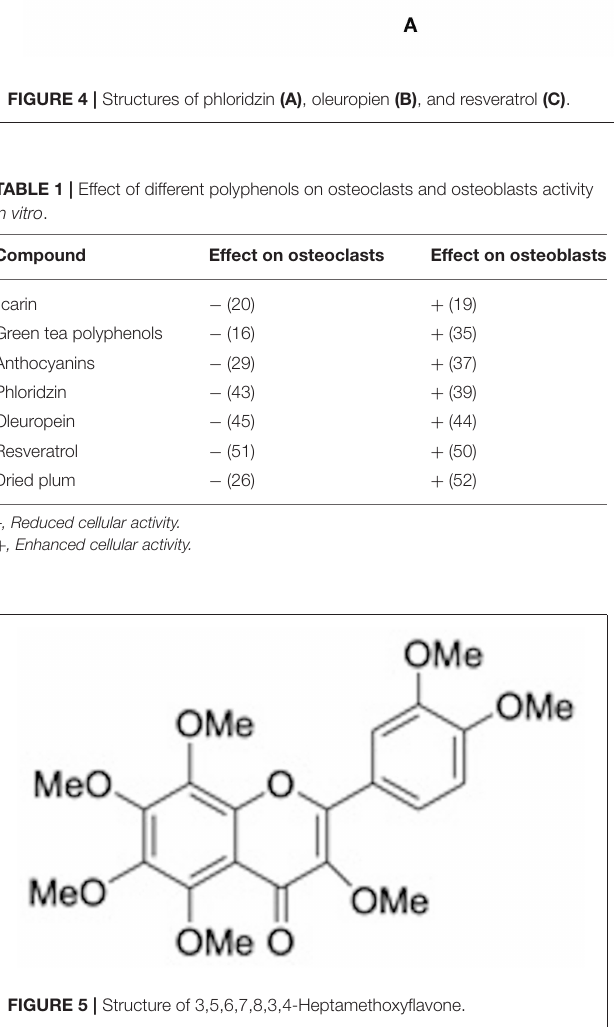
FIGURE 5 | Structure of